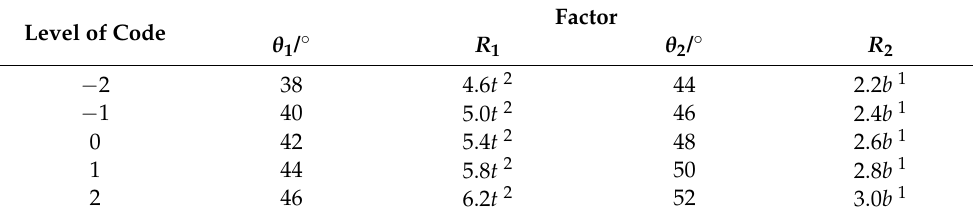
Table 1. Levels of geometric parameter factors of the training wall (operational state of pumping). Level of Code